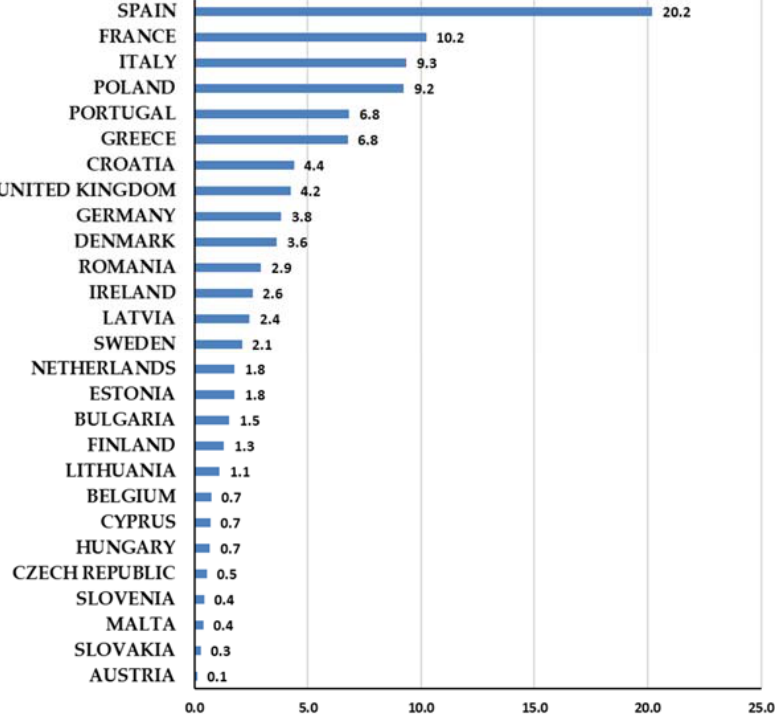
Figure 2. Percentage distribution of the FEMP for the period 2014–2020. Source: Own elaboration from data published by the European Commission. https://ec.europa.eu/oceans ‐ and ‐ fisheries/funding/european ‐ maritime ‐ and ‐ fisheries ‐ fund ‐ emff_es (access on 11 January 2022).